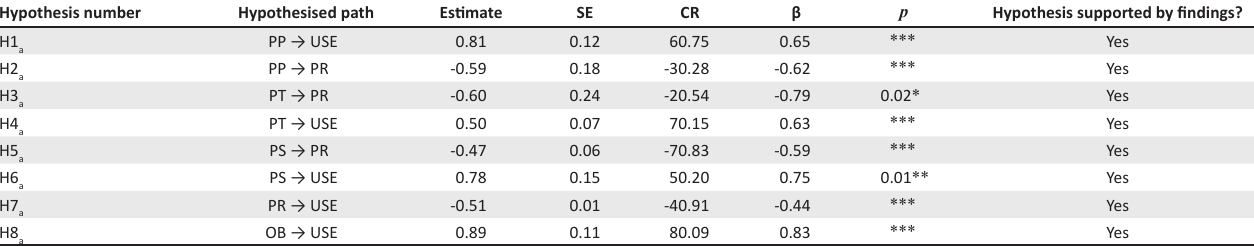
TABLE 4: Path coefficient and hypothesis testing. Hypothesis number